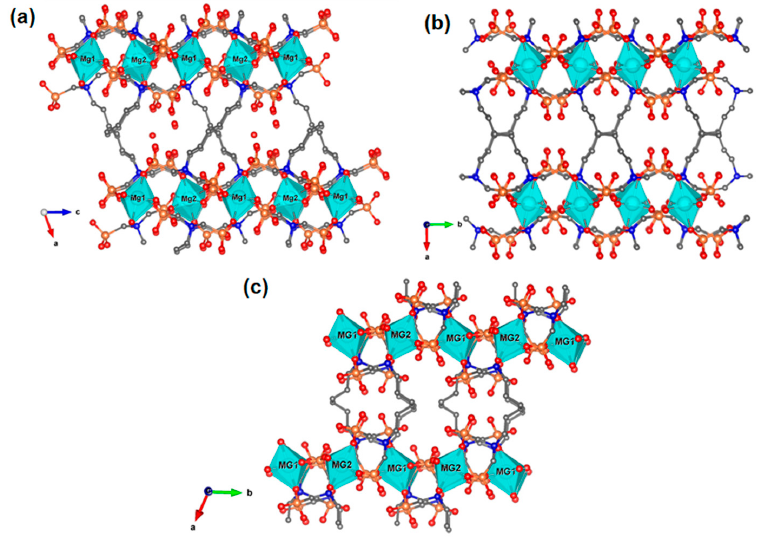
Figure 5. View of the 3-D packing for Compounds 1 ( a ), 1deh ( b ), and 2 ( c ) [28].